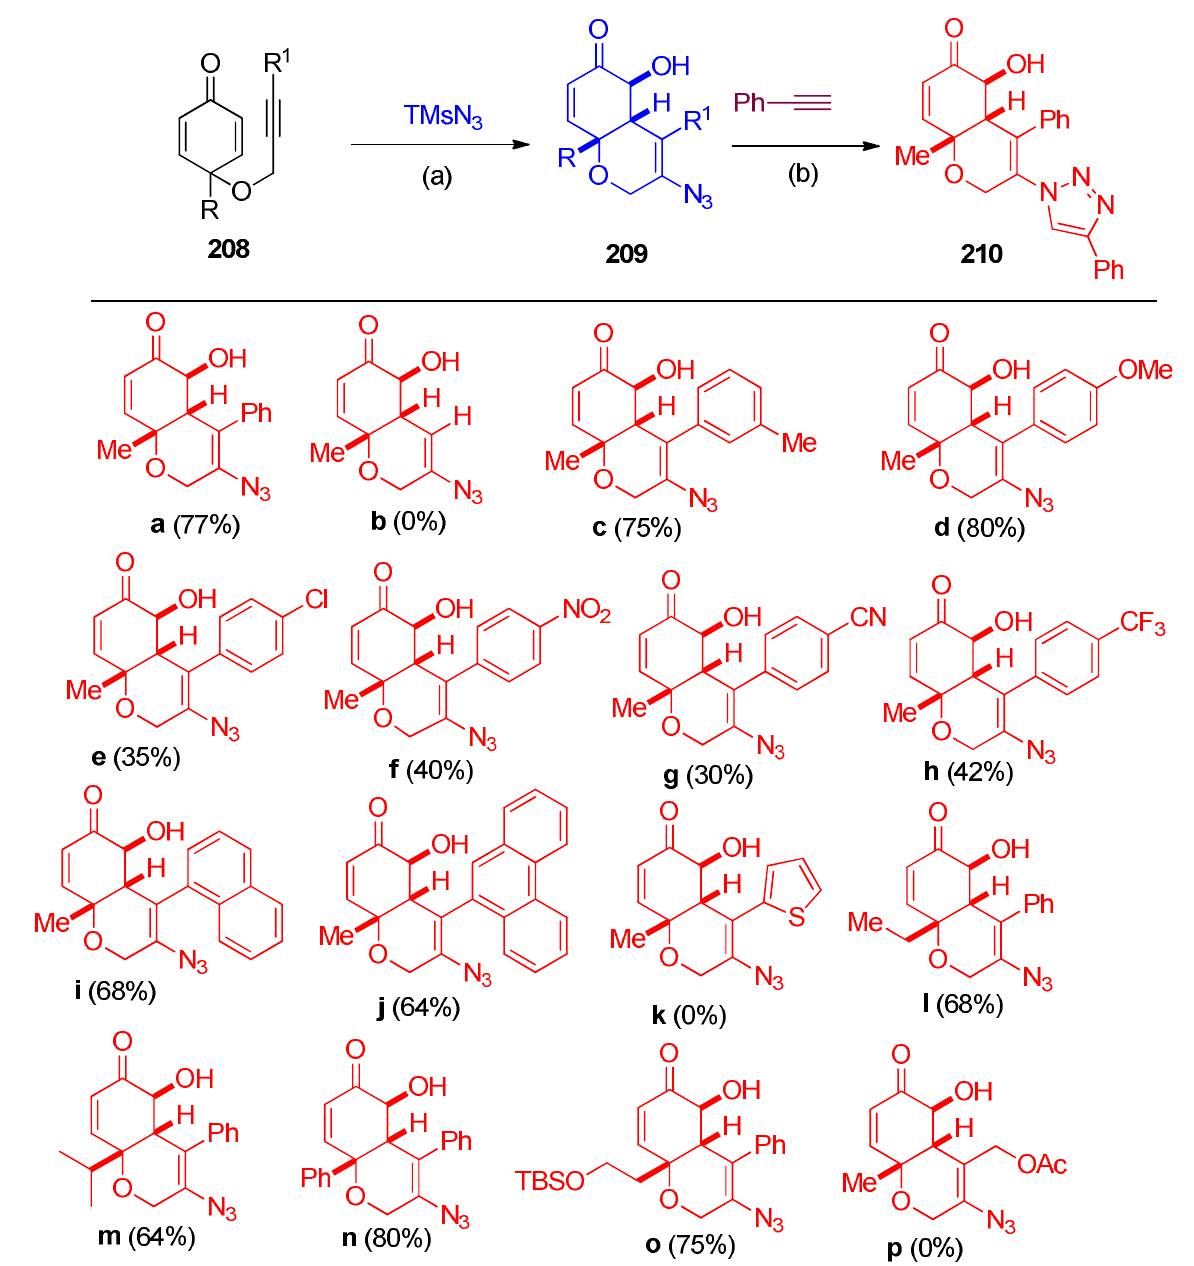
Scheme 79. Synthesis of 1,2,3-triazoles 210a – p . Reagents and conditions : (a) Mn(OAc) 3 ·2H 2 O (50 mol%), TMSN 3 (2.1 mmol, 5 eq.), CH 3 CN (2 mL), O 2 balloon, room temperature, 6–24 h. (b) CuSO 4 ·H 2 O, Sodium ascorbate, t BuOH:H 2 O (1:1), room temperature, 24